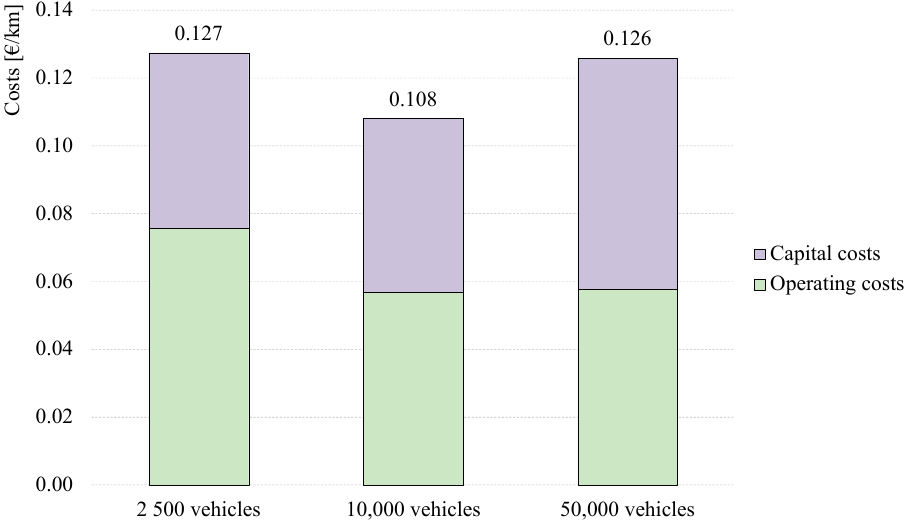
Figure 5. Total cost per kilometer of e-moped fleets of main